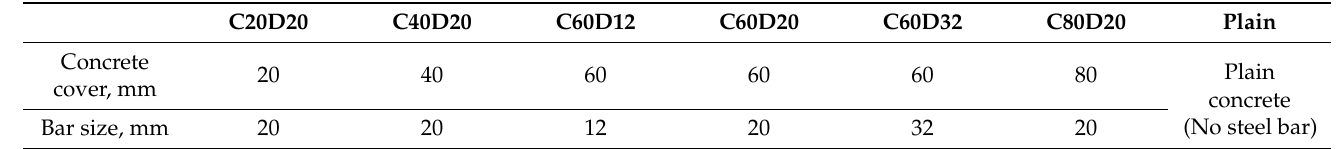
Table 1. Concrete beams casting plan.